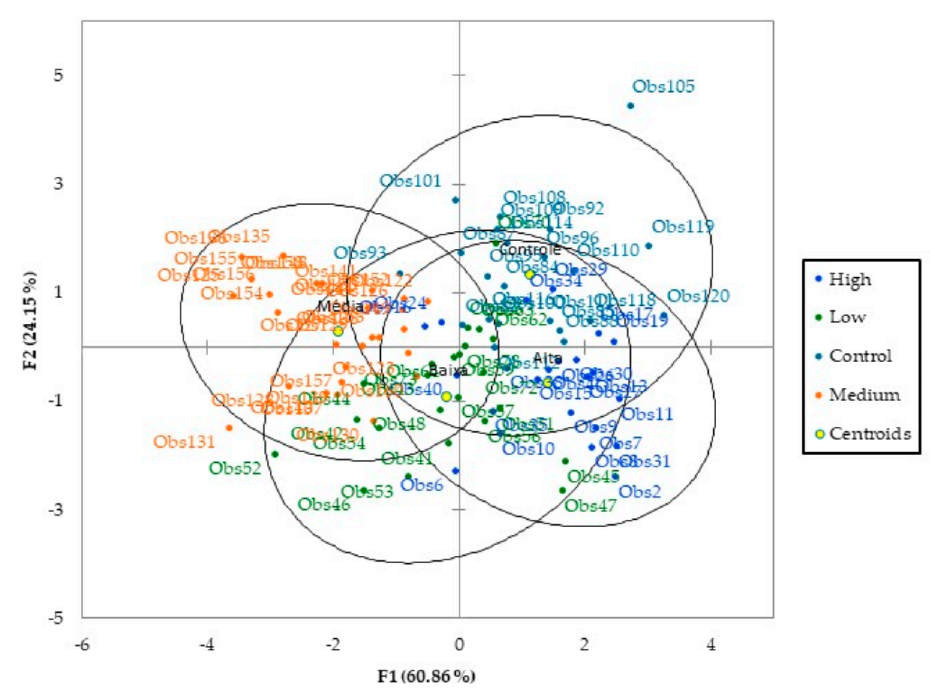
Figure 5. Discriminant analysis of hyperspectral data (450–2400 nm) of soybean leaves under different levels of whitefly infestation. Obs stands for observation, and F1 and F2 for